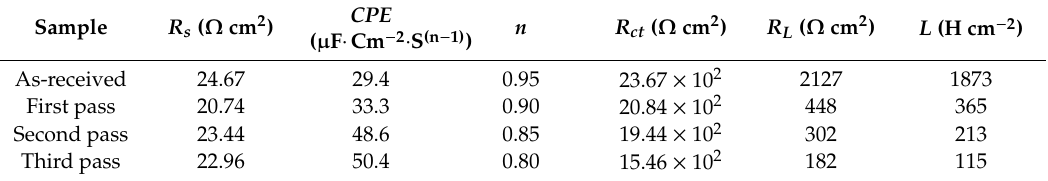
Table 2. Electrochemical impedance spectroscopy results in the 3.5% NaCl Solution.